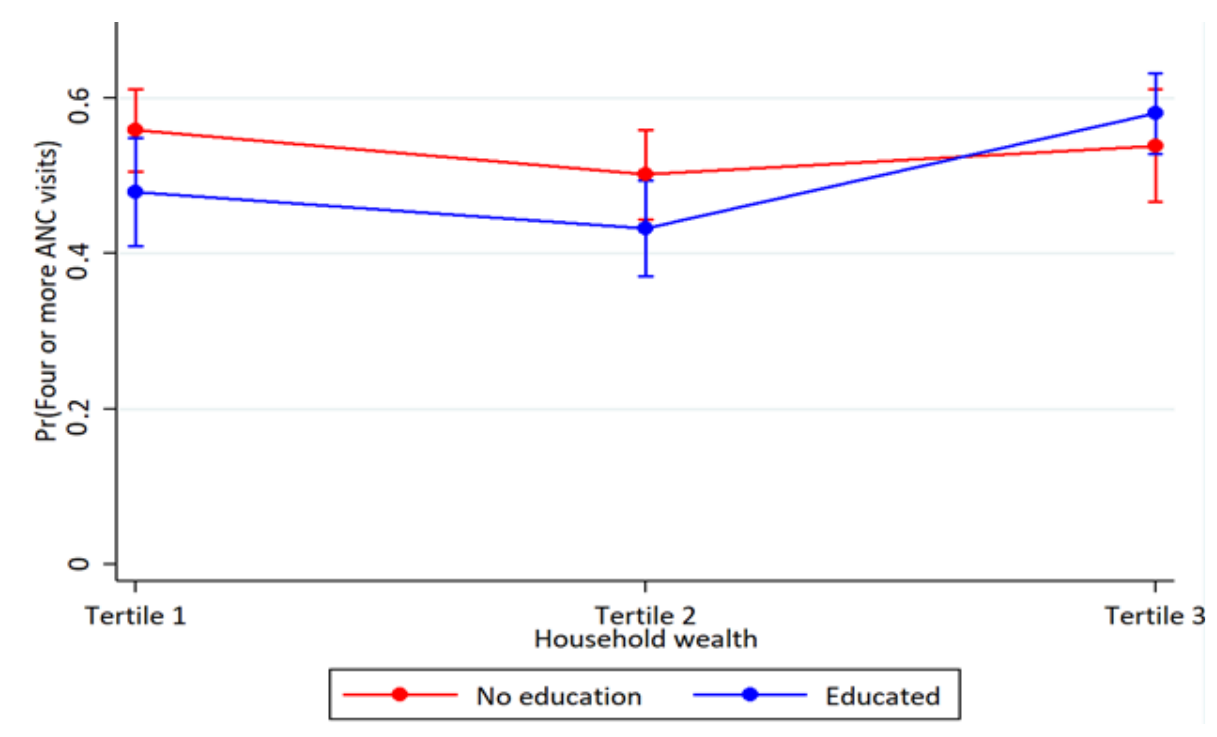
Figure 1. Probability of four or more antenatal care use by household wealth and maternal education with 95% confidence intervals.